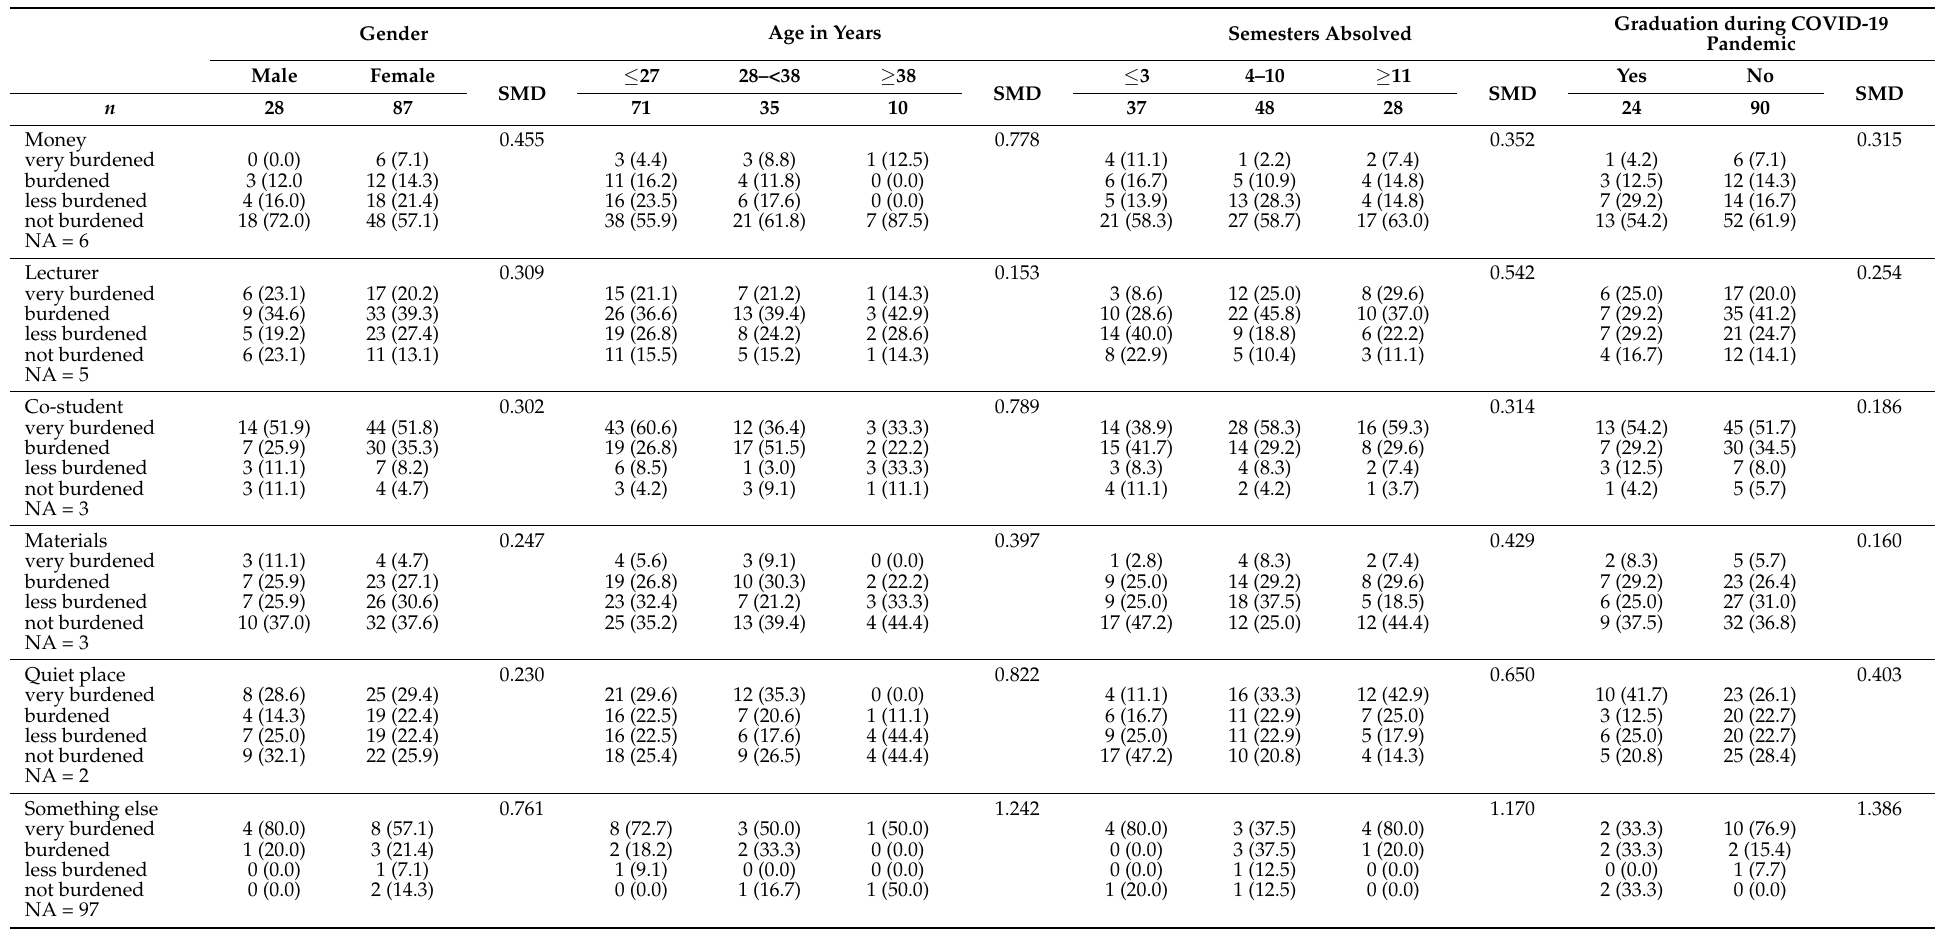
Table 4. Experiences of students, stratified for gender, age, number of semesters completed, and graduation status ( n =